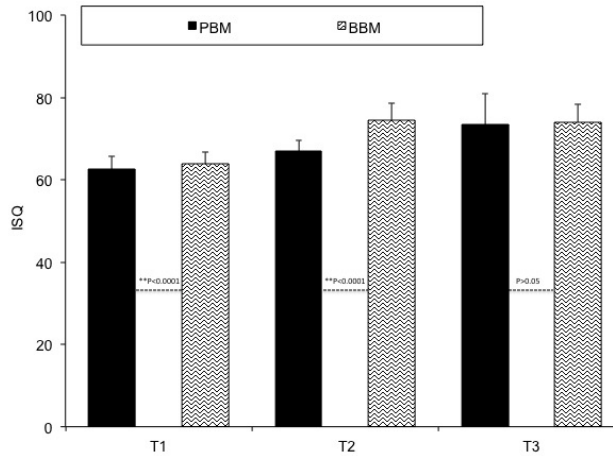
Figure 4. Implant stability quotient for both xenograft materials.